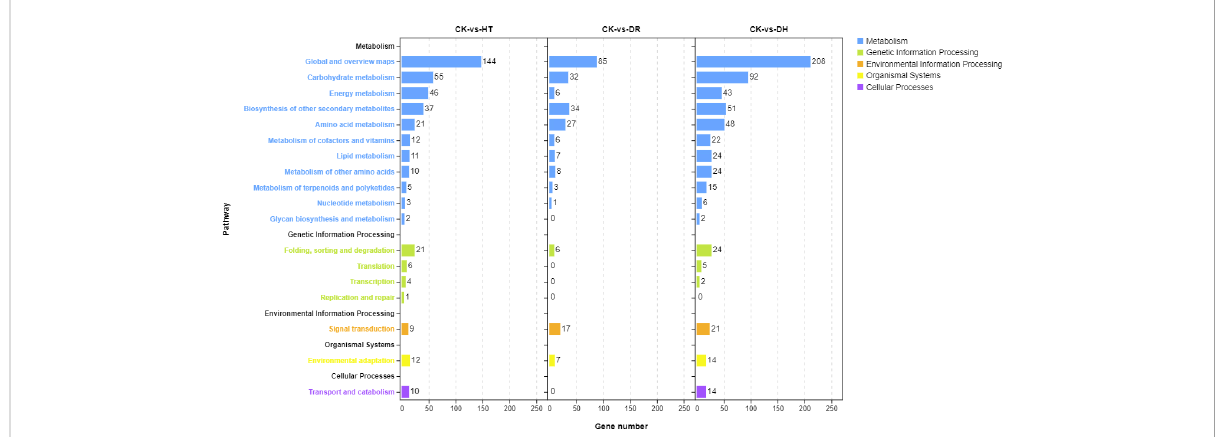
FIGURE 4 KEGG analysis of DEGs in the HT, DR, and DH stress groups compared with CK. CK, control; HT, heat stress; DR, drought stress; DH, drought and heat